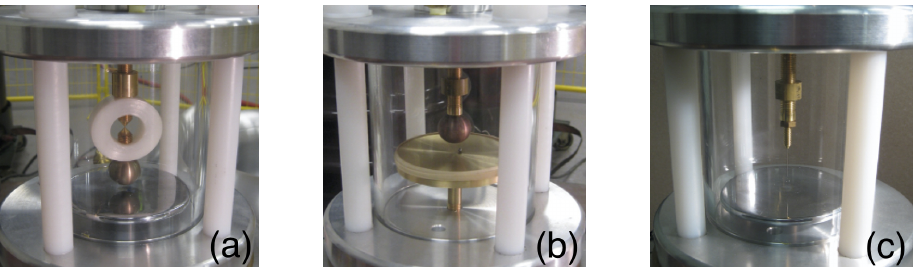
Figure 2. SF 6 test cells: ( a ) floating electrode; ( b ) free particle; ( c ) point-plane electrode [22] (used with permission).